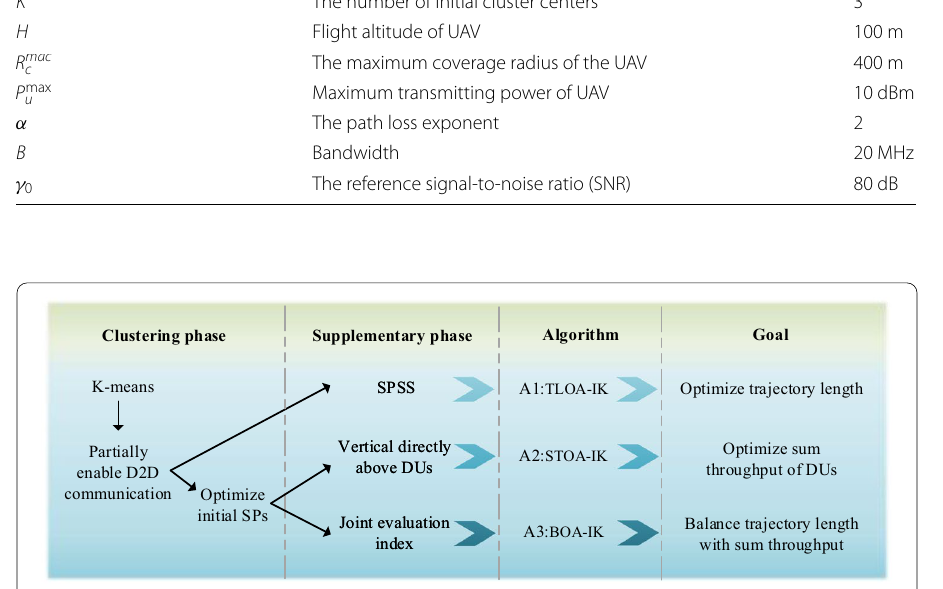
Fig. 5 Comparison of three algorithmic processes and